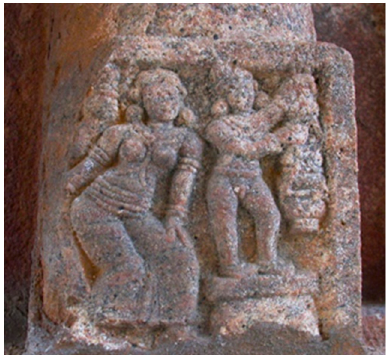
Figure 12. K ṛṣṇ a climbed upon the mortar, Ya ś od ā comes to punish him, 10th century. Granite. Tiruma ṅ kalam, Tamil Nadu.